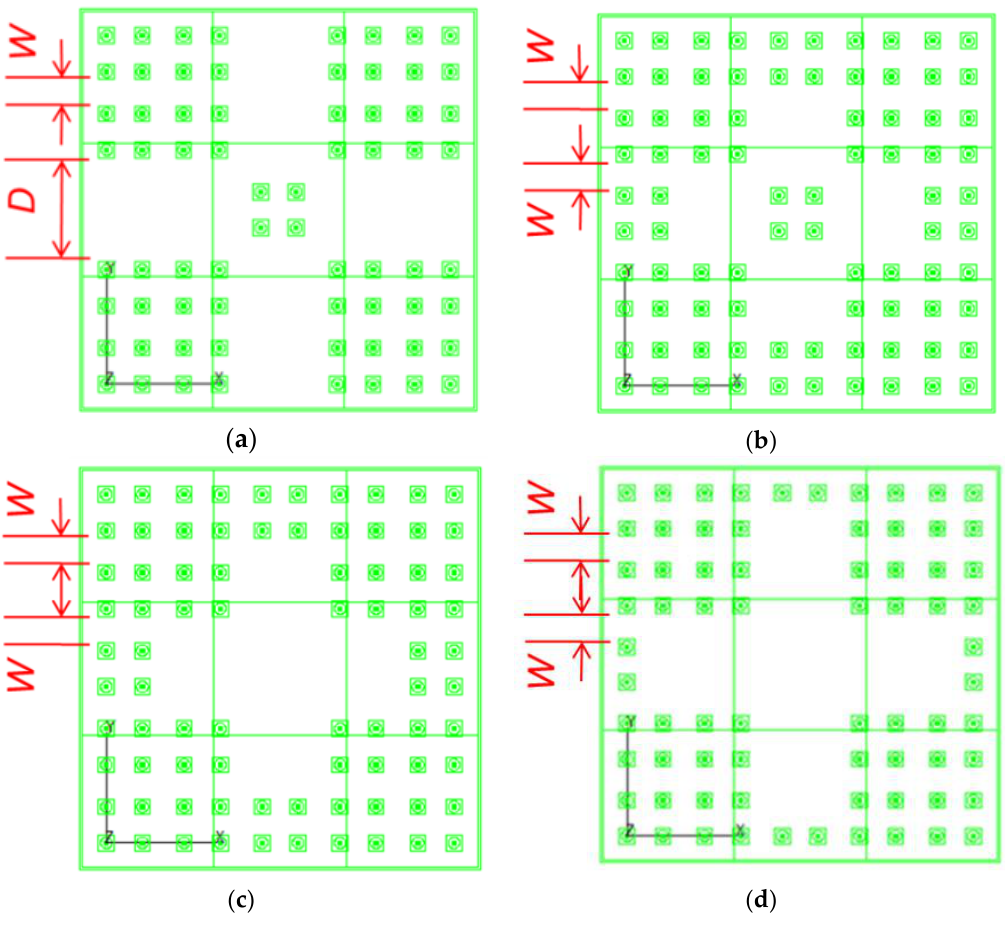
Figure 13. LED arrangement of type (d) of each design change: ( a ) Design change (I), ( b ) Design change (II), ( c ) Design change (III), ( d ) Design change (IV).